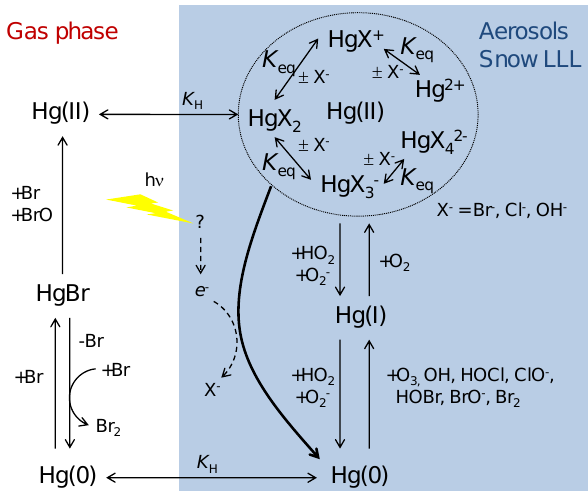
Fig. 1. Outline of mercury chemical mechanism in PHANTAS.